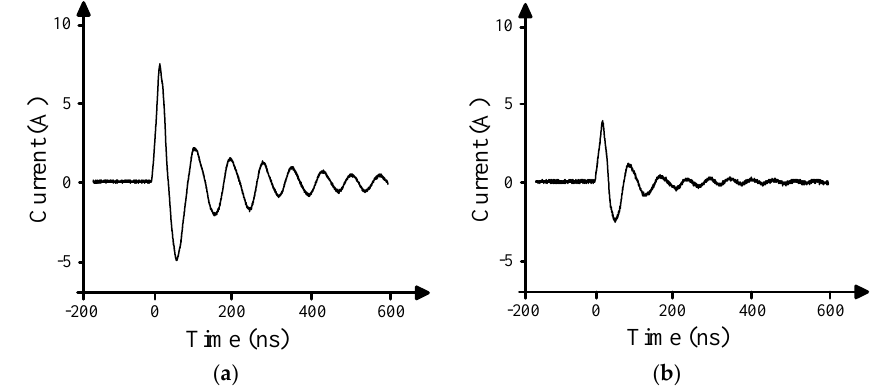
Figure 8. The interference current waveform measured at the PE line: ( a ) Grounding configuration 1 (chassis floating). ( b ) Grounding configuration 2 (chassis grounding).